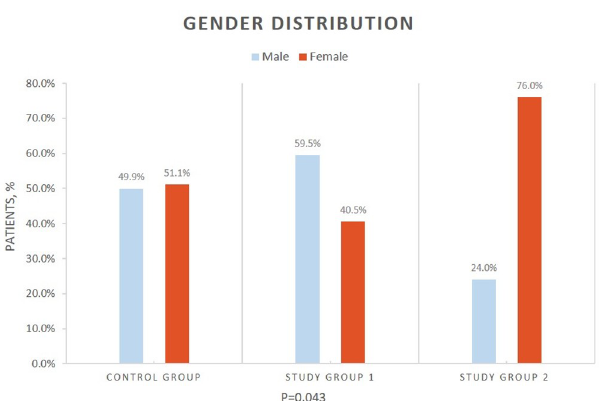
Fig 4. Gender distribution in study groups. A significant female predominance in patients with papilledema (study group 2) comparing to the group without papilledema (study group 1) and control group (76%, 40.5% and 51.1% respectively, p = 0.04).